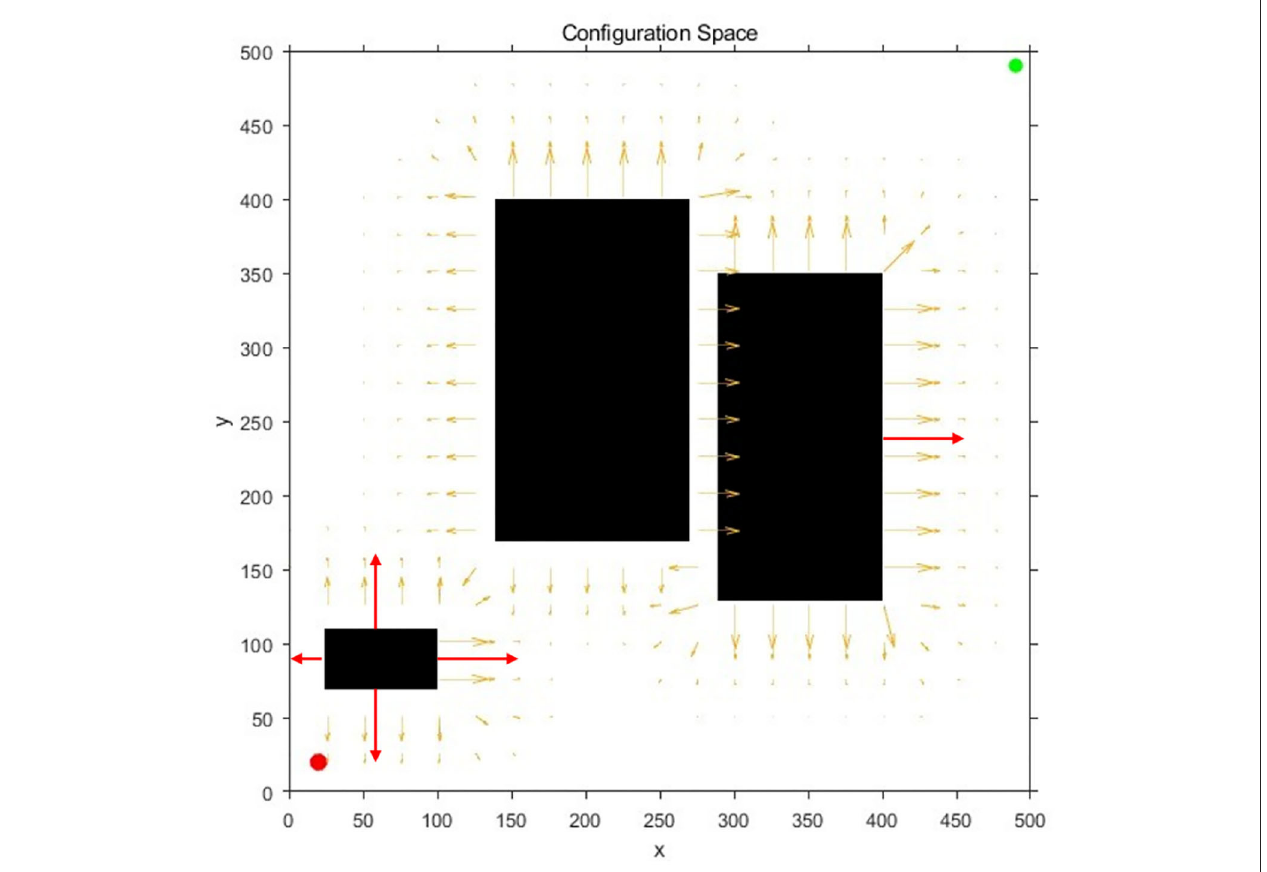
FIGURE 4 | An example of the combination of obstacles moving direction. The red arrows represent the moving directions of the obstacles.